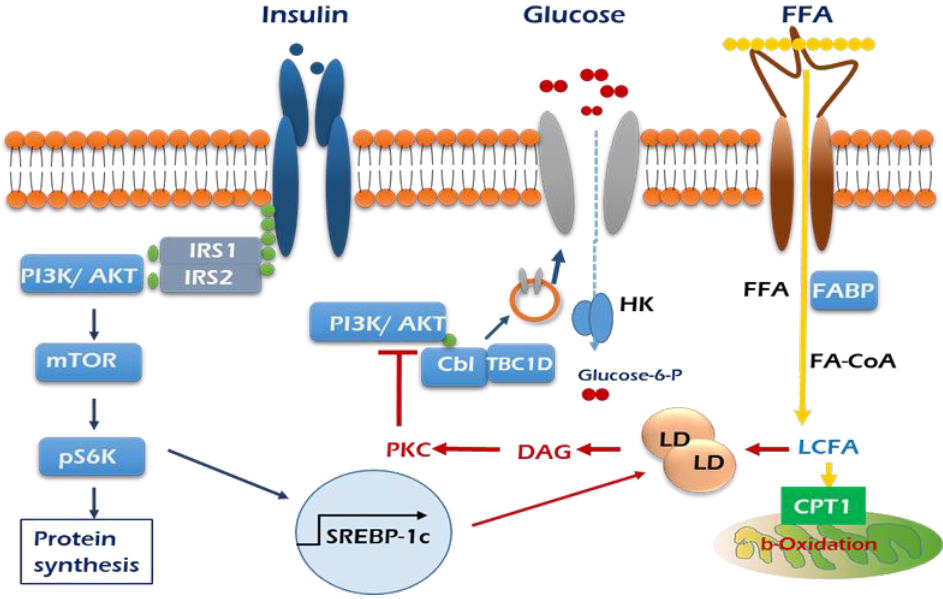
Figure 2. Graphic summary of insulin signaling pathways mediated by influx of lipid in the skeletal muscle. Insulin stimulation of glucose uptake occurs through translocation of GLUT4 to the plasma membrane. The resultant increase in intracellular glucose-6-phosphate production enables net glycogen synthesis. Excess plasma FFAs lead to the intramuscular accumulation of long-chain fatty acid (LCFA)-acyl CoAs. LCFA-acyl CoAs are incompletely oxidized by mitochondria and then form large lipid droplets and activate PKC, which stimulates serine phosphorylation of PI3K / AKT (red arrows), which in turn prevents the translocation of GLUT 4 to the plasma membrane and glucose uptake into skeletal muscle. Insulin receptor, GLUT4, CD36.